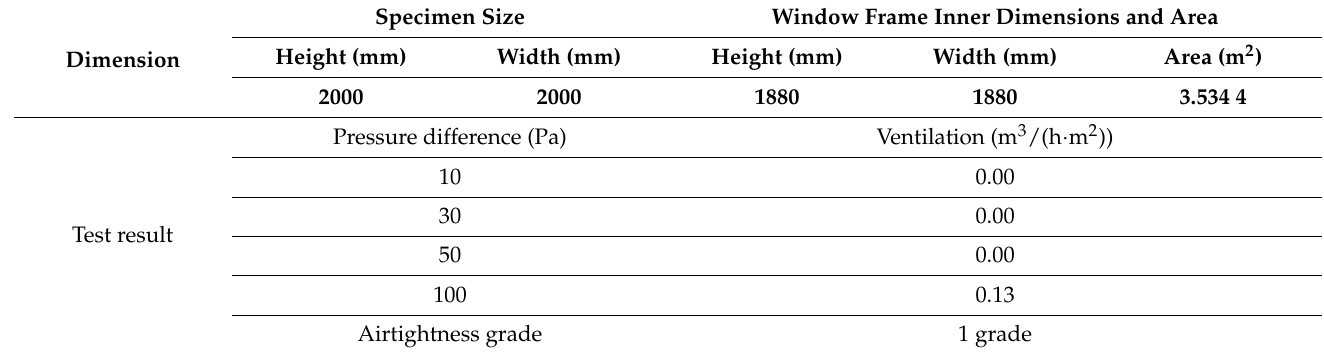
Table 14. Air infiltration test